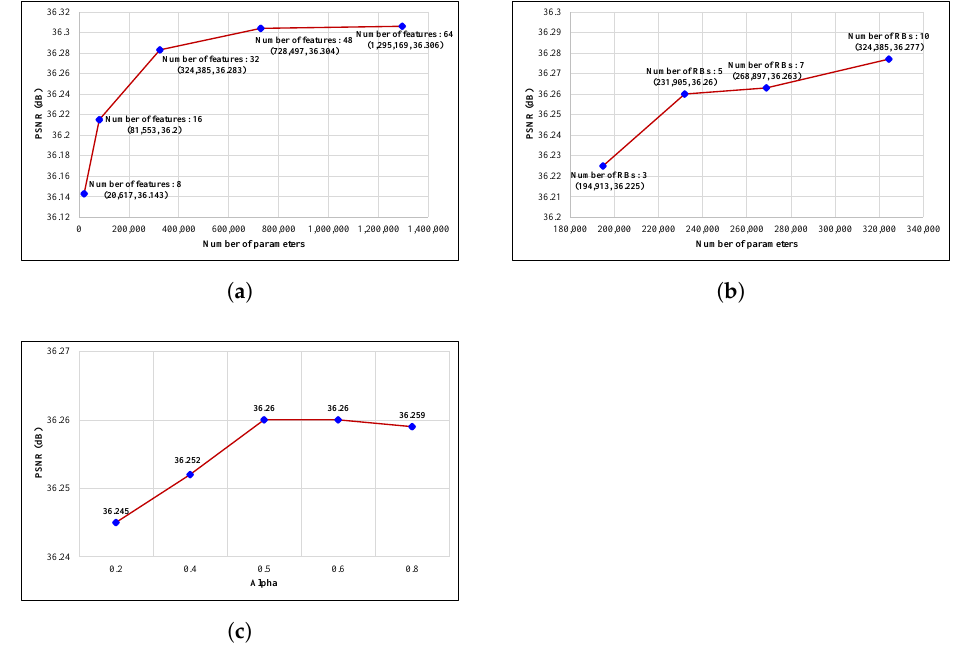
Figure 5. The number of parameters and PSNR with various hyperparameter settings on student models in KD-based training. ( a ) Comparison on number of features with 10 residual blocks and α = 0.5. ( b ) Comparison on number of residual blocks with 32 features and α = 0.5. ( c ) Comparison on α with 32 features and 5 residual